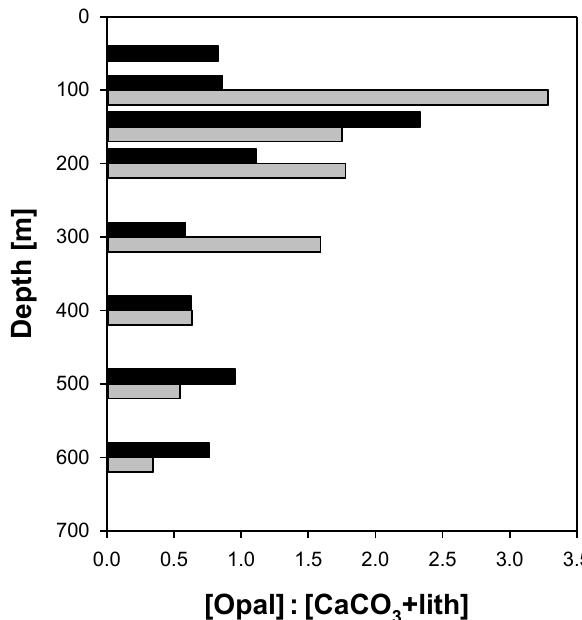
Figure 4. Changes in mineral ballast ratios of sinking particles with depth during the two deployments in the ETNA. Black bars are used for deployment no. 1 and gray bars for deployment no. 2.